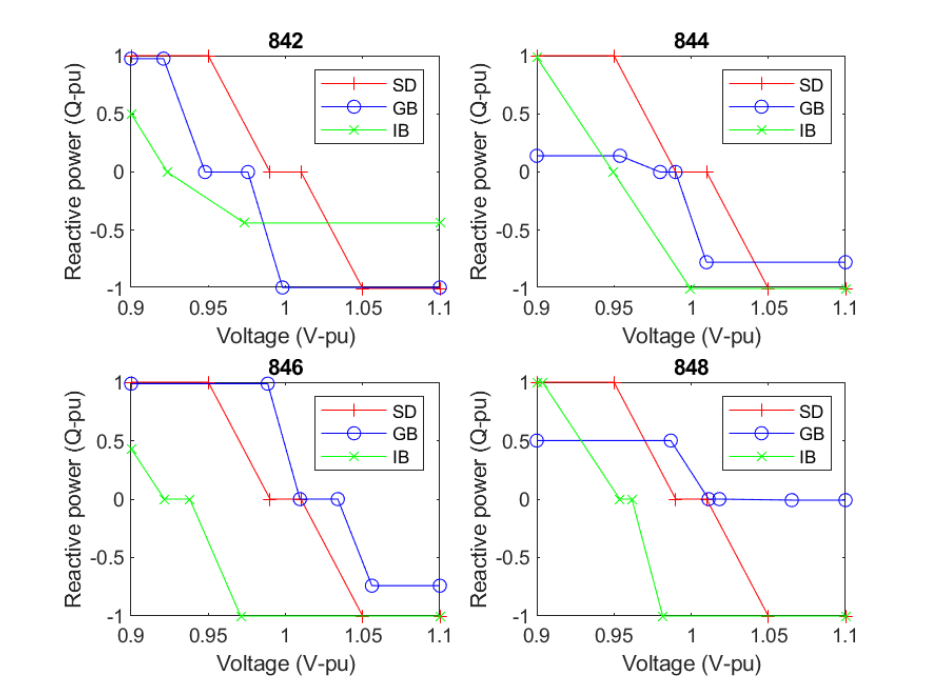
Figure 14. The volt-var curve for cell